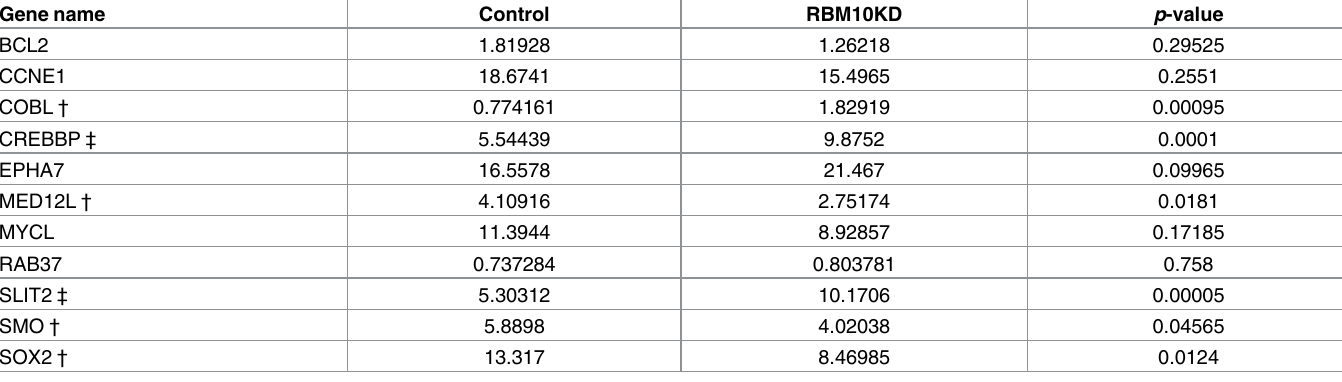
Table 2. Expression of select National Cancer Institute (NCI) ‘Genes of Interest in SCLC’ in Control and RBM10KDsamples, as determined by